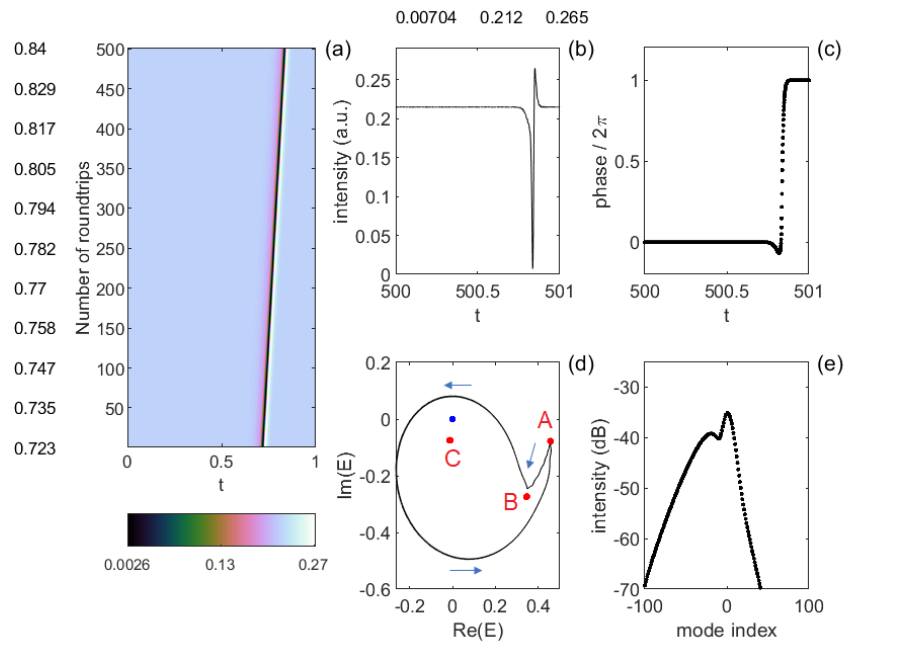
Figure 2. Phase soliton for σ = 0.3 and b = 50. ( a ) Spatio-temporal diagram of the field intensity over 500 roundtrips. The numbers on the left of this panel indicate the position of the phase soliton along the horizontal axis t for the corresponding roundtrip. Time evolution of ( b ) the field intensity and ( c ) the phase over the last roundtrip, i.e., for 500 ≤ t ≤ 501. The three numbers above ( b ) denote, respectively, the minimum, mean and maximum intensity. ( d ) Trajectory of the tip of the electric field in the complex plane. A , B and C are the three homogeneous stationary solutions, whose dynamical role is explained in the text; the blue dot is the origin. ( e ) Power